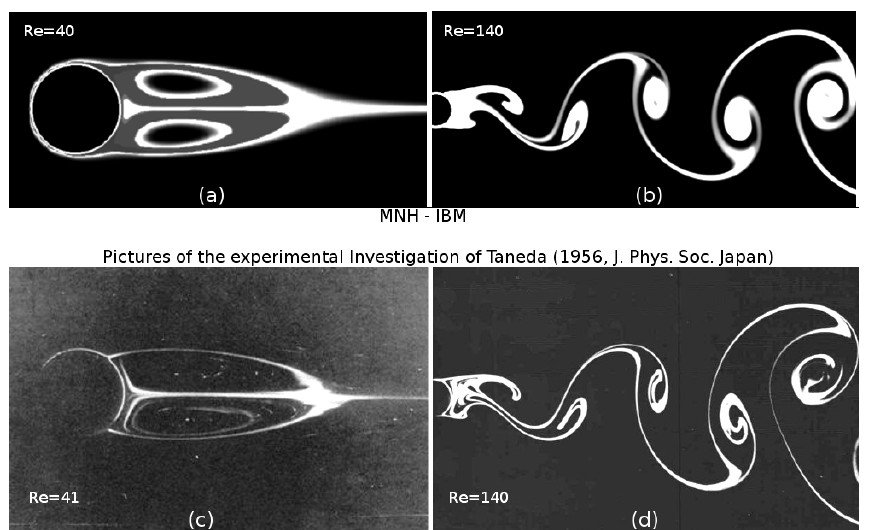
Figure 11. Eddy structure in a viscous fluid: steady (left, Re ≈ 40) and unsteady (right, Re ≈ 140) solutions obtained by the current numerical investigation ( a and b , MNH–IBM and 30pts /D cyl ) and by the Taneda (1956) experiments ( c and d ). The visualization is due to the presence of a passive tracer injected on the body surface and transported by the flow.